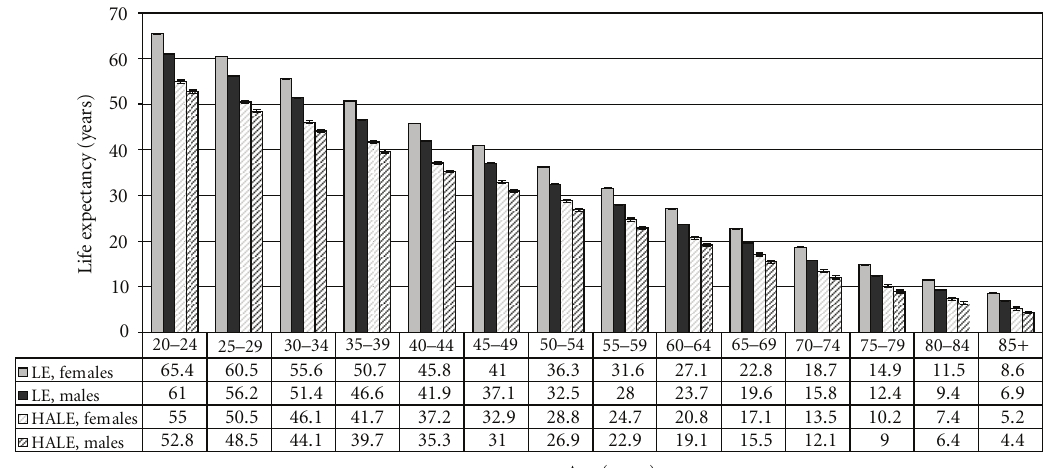
Figure 1: Life expectancy (LE) and health adjusted life expectancy (HALE) for females and males, without hypertension, Canada, 2004 to 2006. (Data source: Canadian Community Health Survey Data Files (CCHS) from Statistics Canada, 2000–2005 and Canadian Chronic Disease Surveillance System Data Files (CCDSS) from Public Health Agency of Canada, 2004–2006. Data Files excluded Quebec, Nunavut and Northwest Territories.)